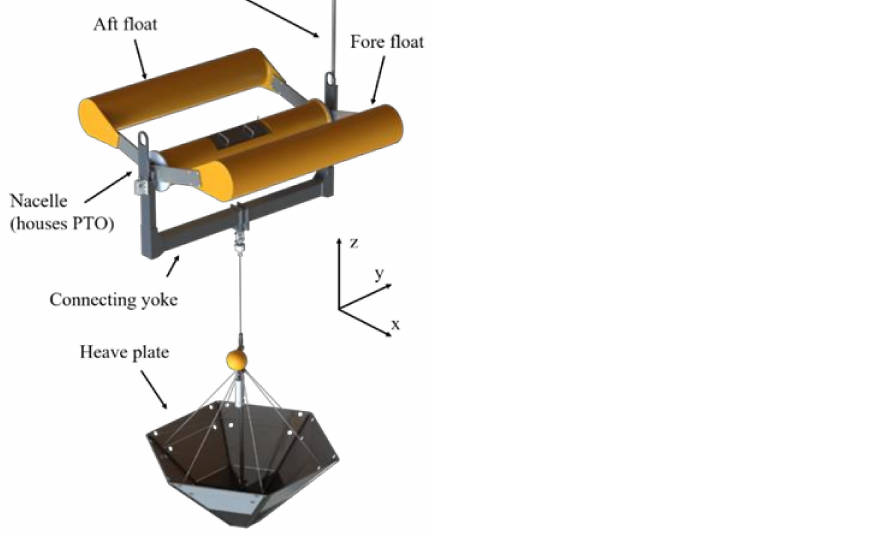
Figure 4. Wave Energy Buoy that Self-deploys WEC device as deployed (tether length not to scale)